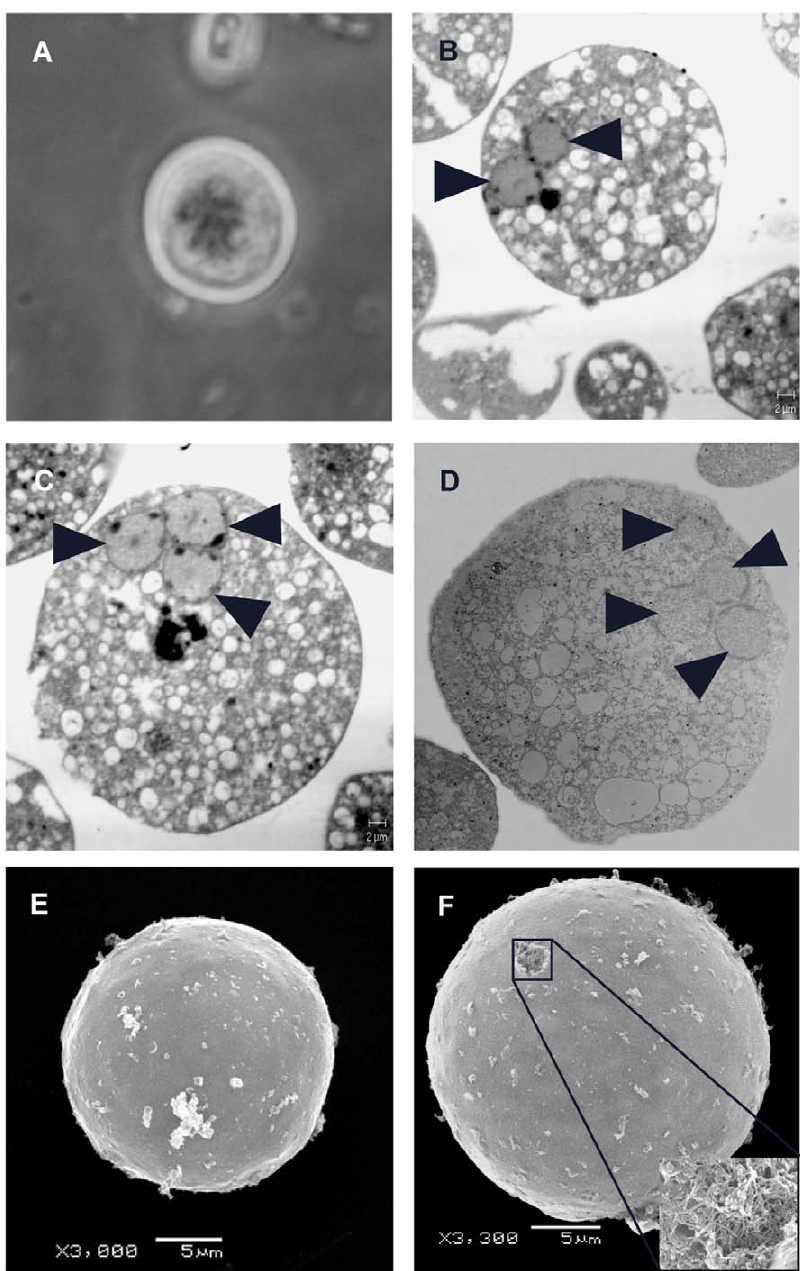
Figure 1. Ultrastructural analysis of E.histolytica CLS resistant to detergents. (A) Light microscopy of a CLS stained with Lugol’s Iodine showing its spherical shape, multi-nucleation and partial refringence; (B, C and D) Transmission electron microscopy of CLS showing two, three and four nuclei, respectively (arrow heads). High number of cytoplasmic vacuoles are also observed; (E) and (F) Scanning electron microscopy showing the smooth surface, spherical shape and small size of the CLS. Inbox in F shows a magnification of a hole in the surface of a CLS, where overlapping fibers that resembles chitin-fibers in other organisms are observed [6,7].